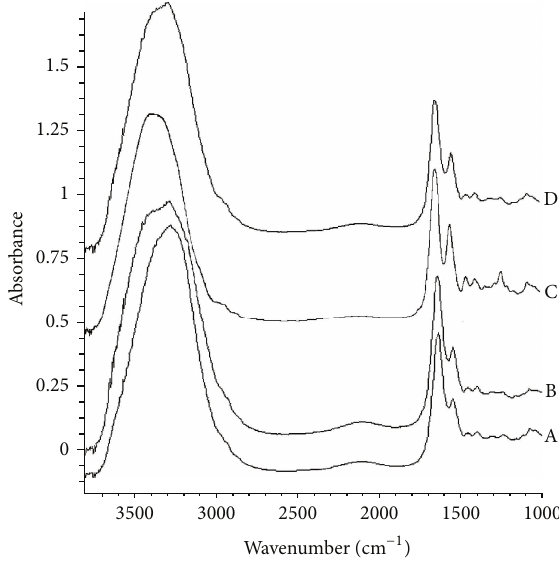
Figure 2: FTIR spectra of four samples from Parts A, B, C, and D, with wavenumber ranging from 3800 cm −1 to 1000 cm −1 .